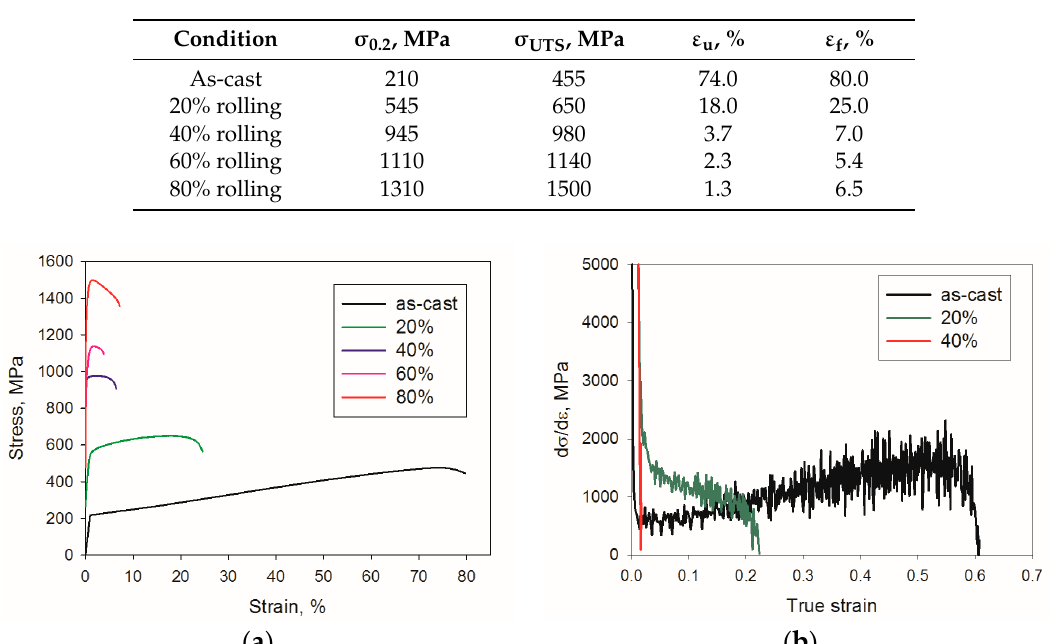
Figure 6. ( a ) Tensile stress-strain curves and ( b ) strain hardening curves of the Al-, C-containing CoCrFeNiMn-type alloy in the as-cast condition and after cold rolling with different thickness reductions.